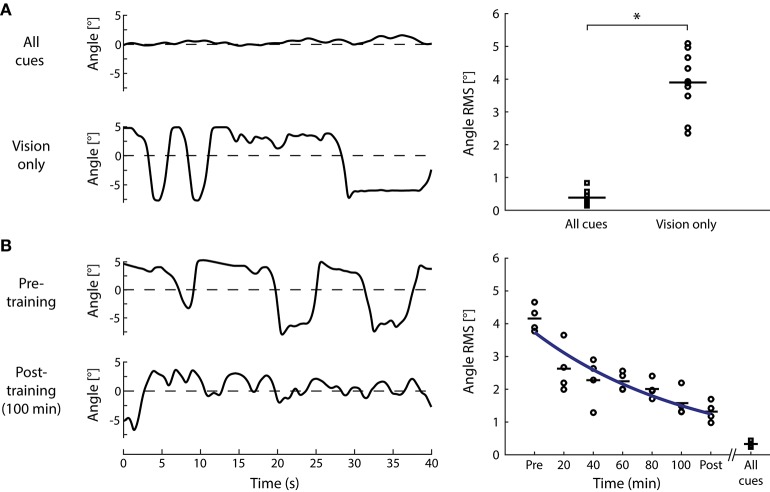
Standing balance using only visual cues. (A) Subjects stood in a robotic balance simulator while either all sensory cues (see Figure 3A) or only visual cues of balance were provided (see Figure 3C). Angular oscillations of a representative subject (left) when balancing with all cues or only vision show an increase in angular sway when balancing with only vision. Mean removed root-mean-square (RMS) of angular oscillations of all subjects tested (n = 10, right) exhibited the same increase when using visual cues to balance (paired t-test; t9 = −13.2, P < 0.001). Squares represent the “all cues” condition and circles represent the “vision only” condition. (B) Four of the original 10 subjects subsequently went through 5 days of training (~20 min per day) under the vision only condition. Angular oscillations of a representative subject (left) show a decrease after 100 min (5 days) of training compared to the pre-training vision only condition. Mean-removed RMS of angular oscillations progressively decreased with each session of training (circles), but always remained above the all cues conditions (squares). For illustrative purposes, the blue line shows the fitting of mean angle RMS to an exponential function (y = 4.4893 e−0.1829 x) using a least-square method. In both graphs, horizontal lines represent the mean of standard oscillation across all subjects and *P < 0.001.